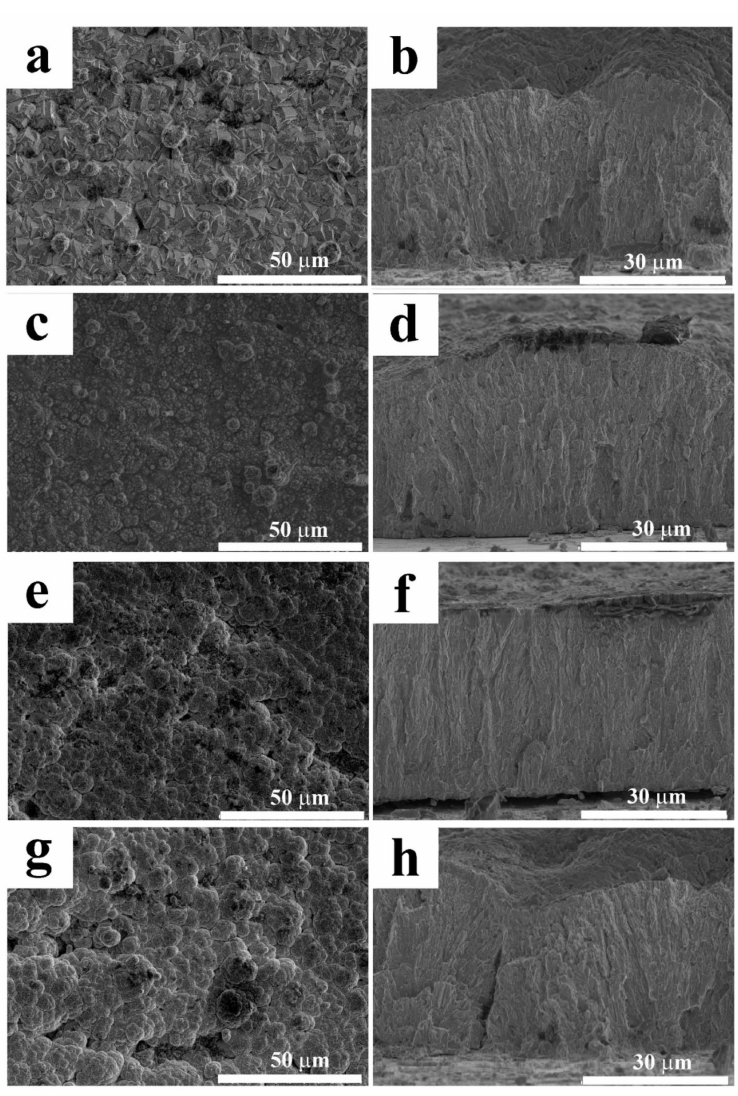
Figure 4. SEM images of the surfaces and cross-sections of ( a , b ) A 0 , ( c , d ) A CS1 , ( e , f ) A CS2 , and ( g , h ) A CS3 .